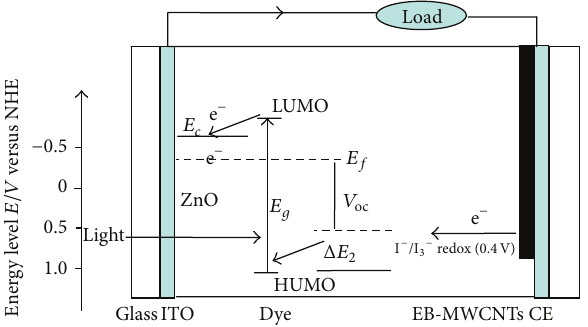
Scheme 2: Photocurrent mechanism of ITO/EB-MWCNTs/ZnO- riboflavin/ITO.